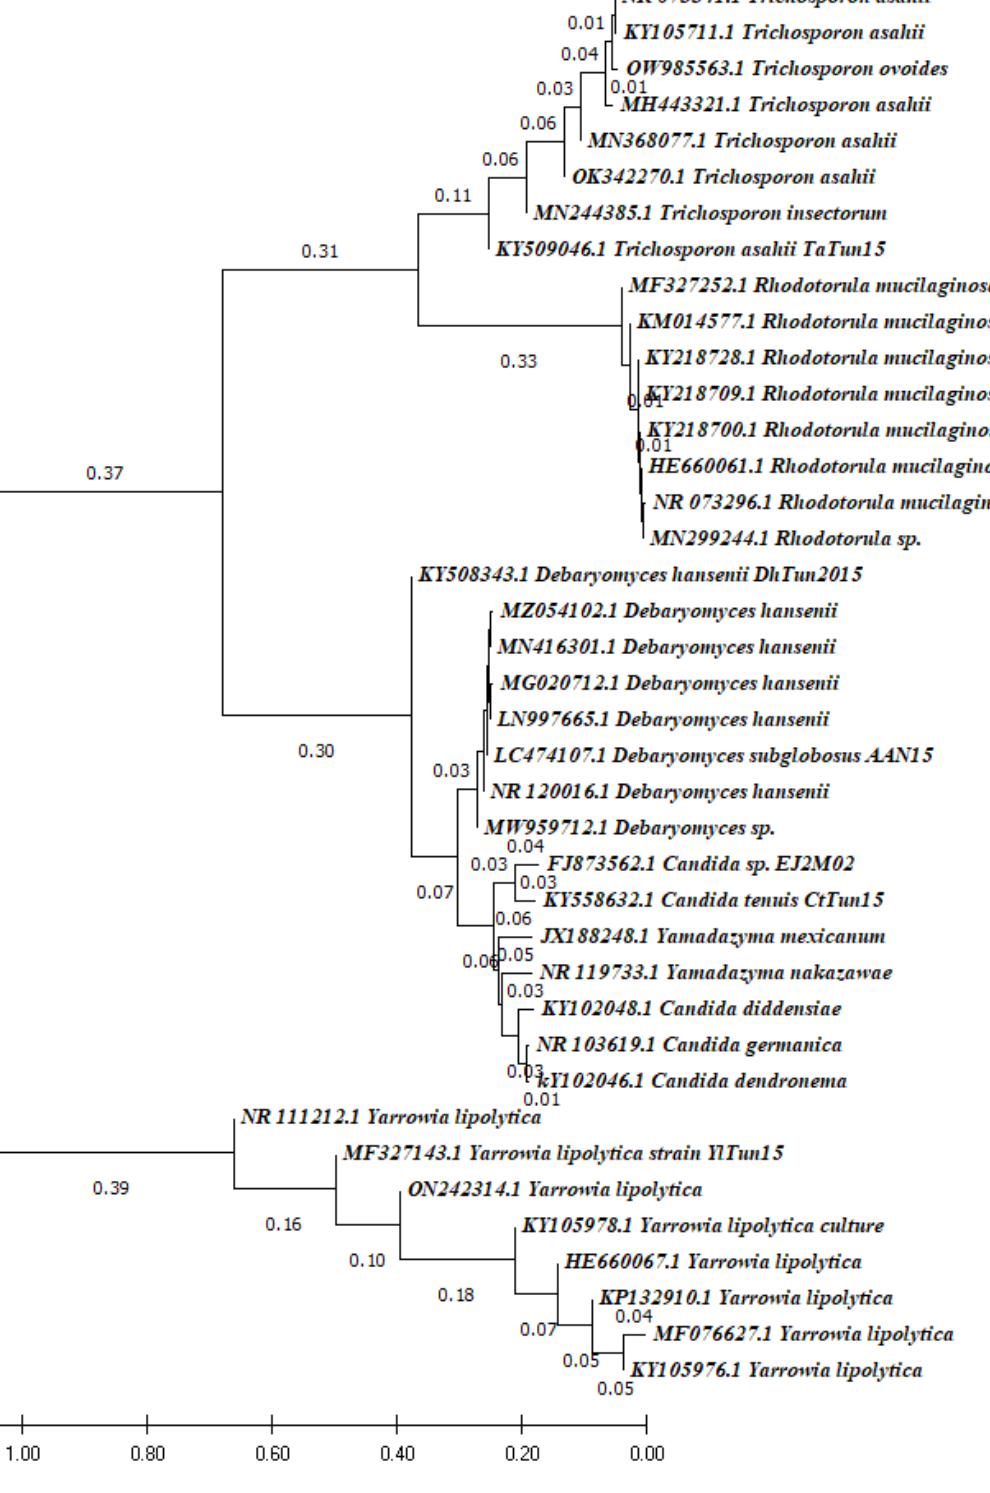
Figure 1. Molecular phylogenetic tree by neighbor-joining method, Mega 11.0 .